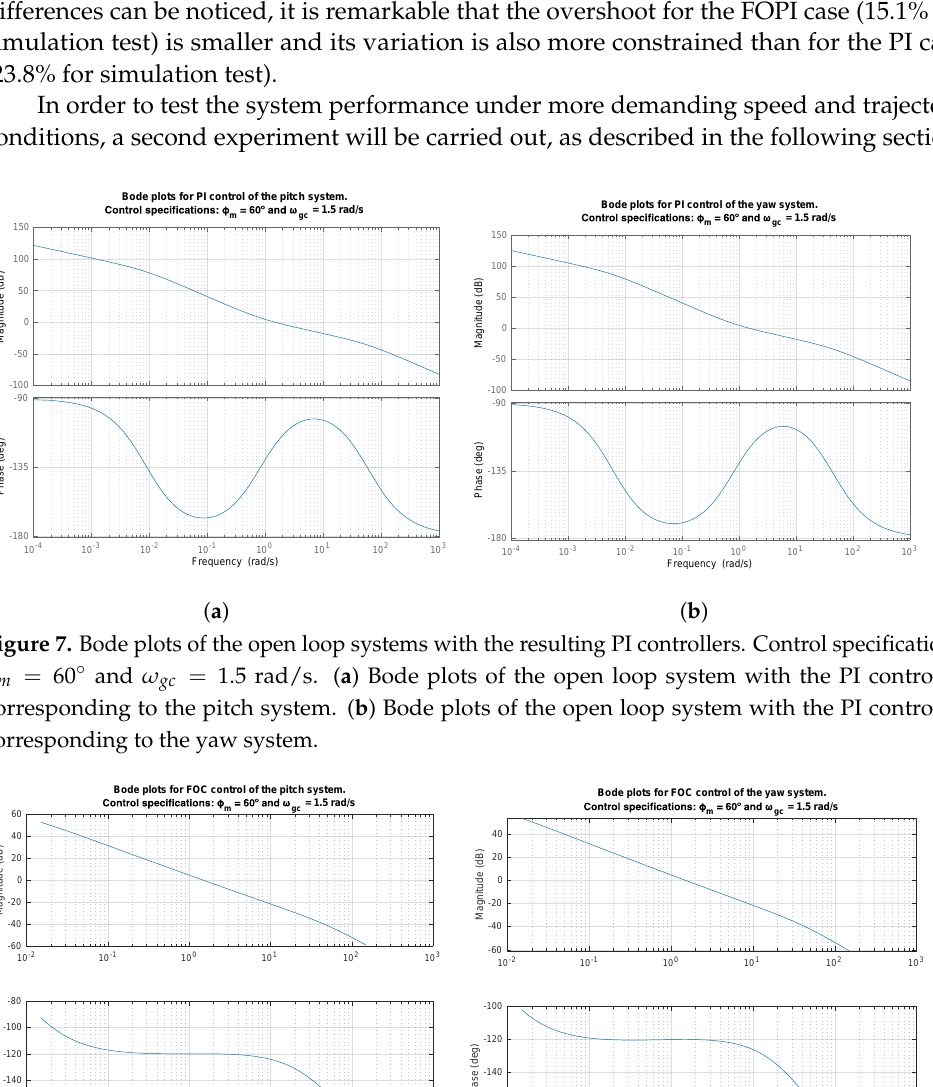
Figure 8. Bode plots of the open loop systems with the resulting FOPI controllers. Control specifica- tions: φ m = 60 ◦ and ω gc = 1.5 rad/s. ( a ) Bode plots of the open loop system with the FOPI controller corresponding to the pitch system. ( b ) Bode plots of the open loop system with the FOPI controller corresponding to the yaw